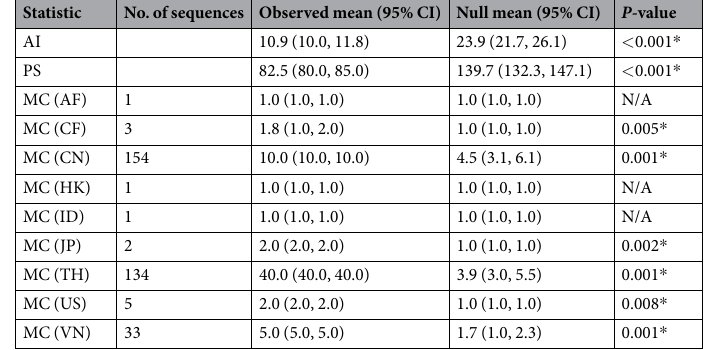
Table 4. Statistical analysis of geographic location of CRF01_AE sequences. AI, association index. PS, parsimony score. MC, monophyletic clade statistic. 95% CI, 95% credbility interval. * Statistically significant (P < 0.05). N/A, not available because of the observed 95% CI contains the null 95% CI.